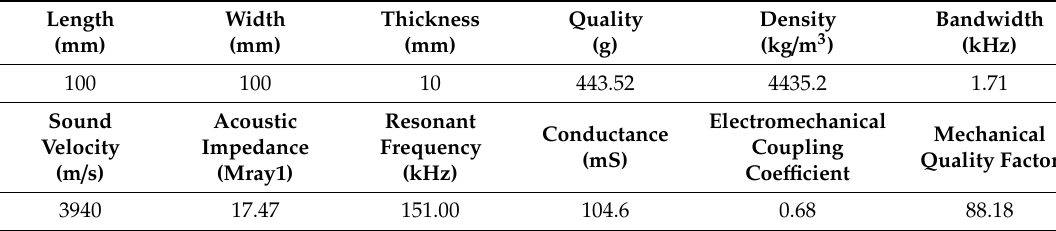
Table 1. Performance parameters of the 1-3 piezoelectric composites.